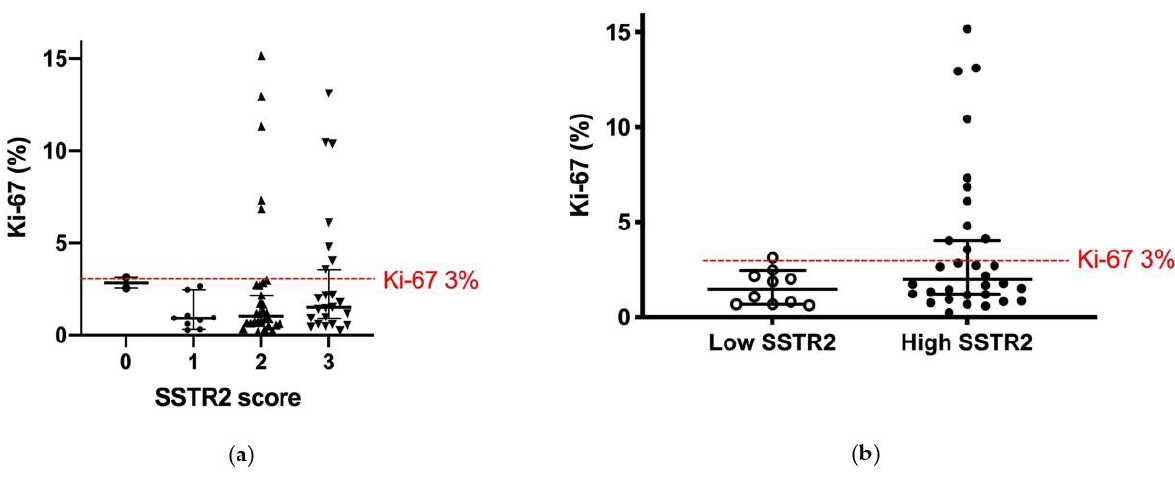
Figure 6. Ki-67 and SSTR2 expression of a subgroup of samples ( n = 66) in the TMA. Ki-67 was assessed in full section slides corresponding to the TMA core biopsy. ( a ) Most samples ( n = 53) had Ki-67 < 3% (WHO grade 1). All but one sample (SSTR2 score 0) with grade 2 tumors (Ki-67 3–20%) had consistently high SSTR2 expression (score 2–3). There was no significant difference between the groups ( p = 0.25; Kruskal–Wallis test); ( b ) When sorting the samples according to patient groups High SSTR2 ( n = 32) and Low SSTR2 ( n = 10), almost all patients with grade 2 tumors also had high SSTR2 expressing tumors. For patients with more than one sample, the highest Ki-67 was used. There was not a significant difference between the groups ( p = 0.10; Mann–Whitney U test). Bars show median and 95% CI. Red line shows 3% threshold between grade 1 and grade 2.